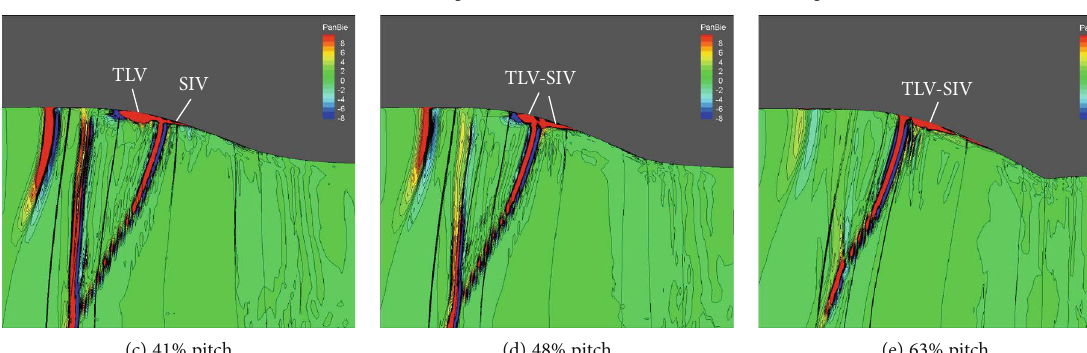
Figure 23: Identi fi cation of vortex existence in the tip region by parameter PanBie at near stall condition.